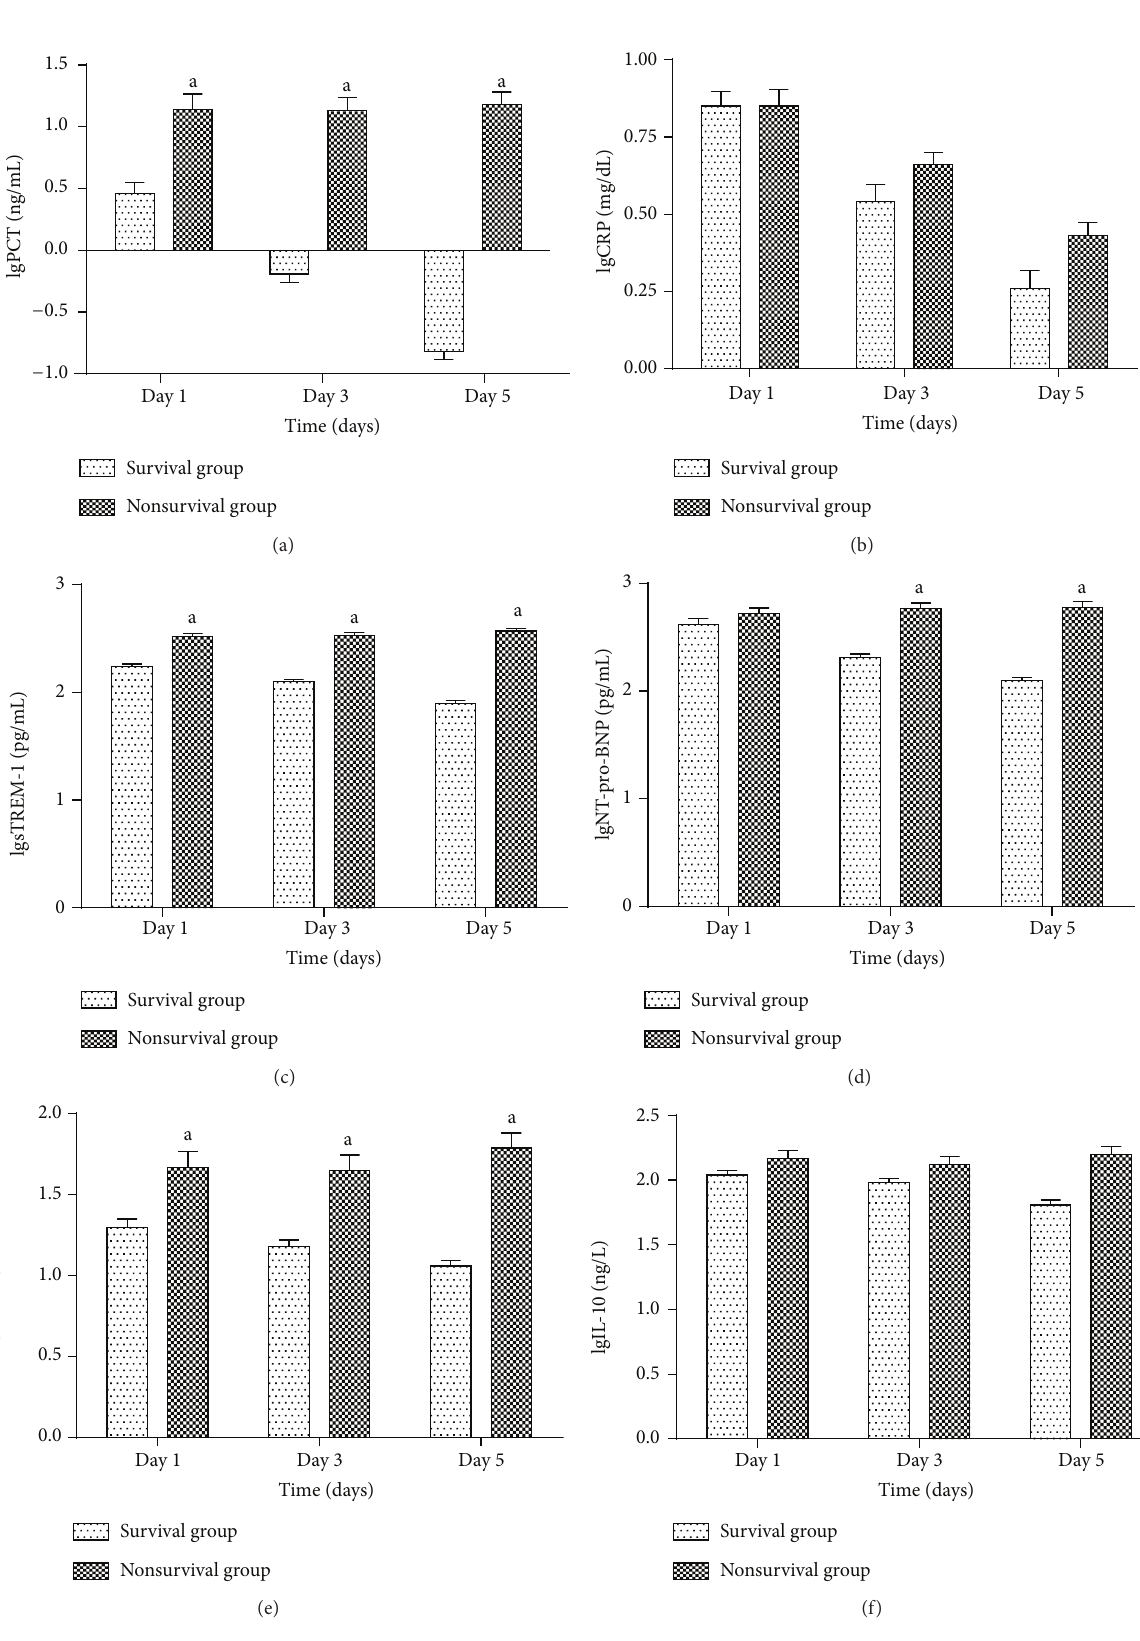
Figure2:Dynamicchangesofbiomarkersandcytokineslevelsinsurvivalgroupandnonsurvivalgroup.Non-normallydistributiondatawere madealogarithmicconversionintonormallydistributiondataandexpressedasmeans ± standarddeviations(SD). a 𝑃 < 0.01 forcomparisons between two groups on the same day (Student’s t